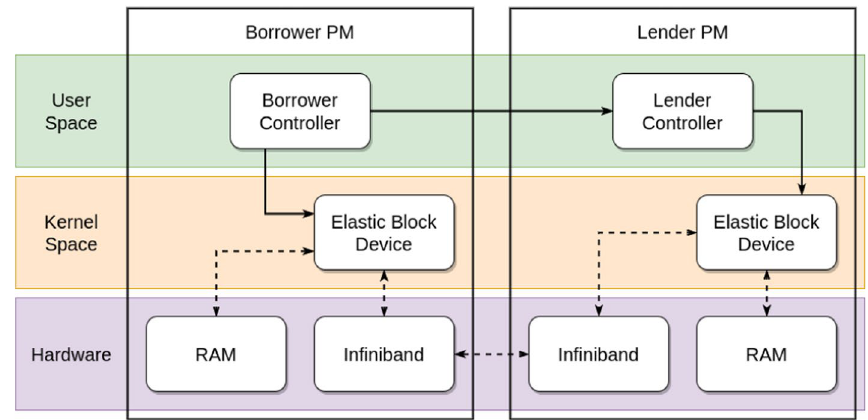
Fig. 1 System architecture of memory